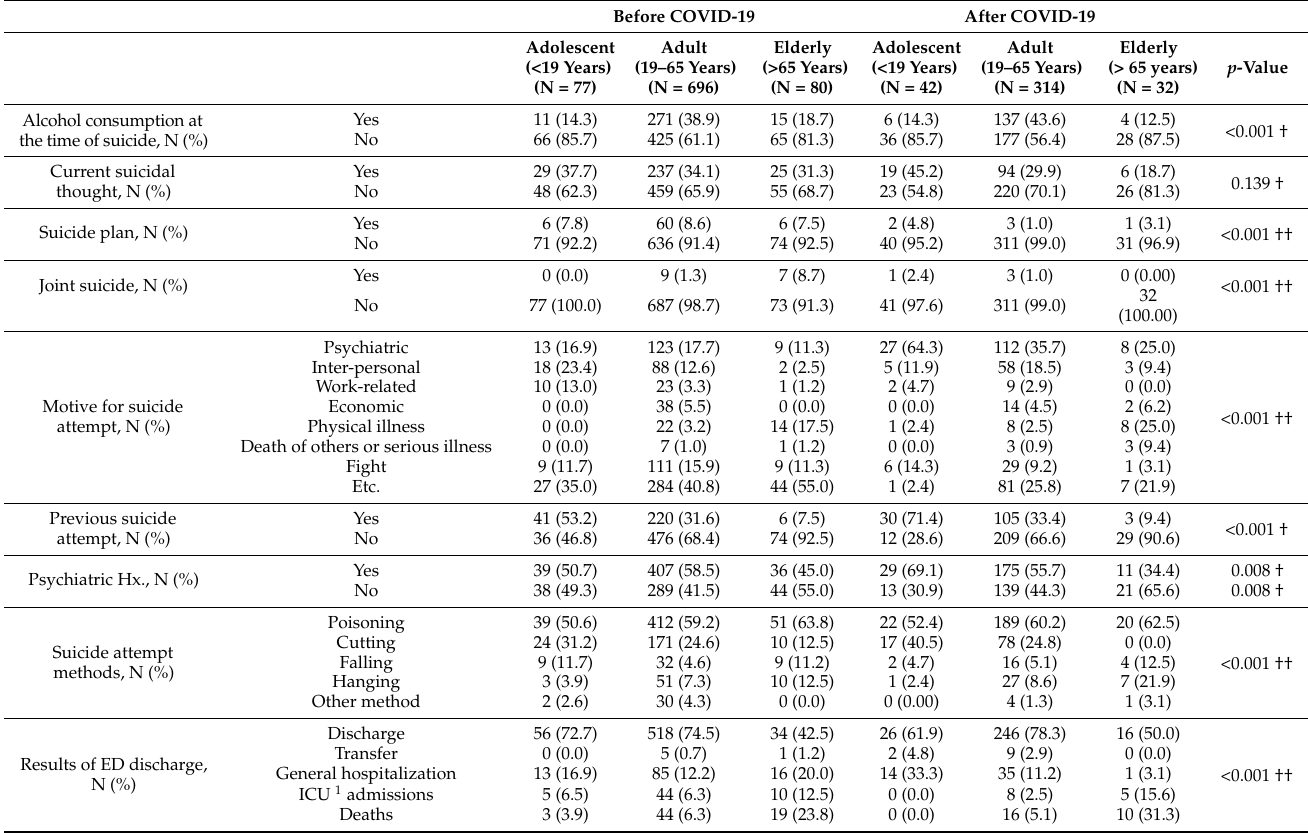
Table 2. Suicide attempt related